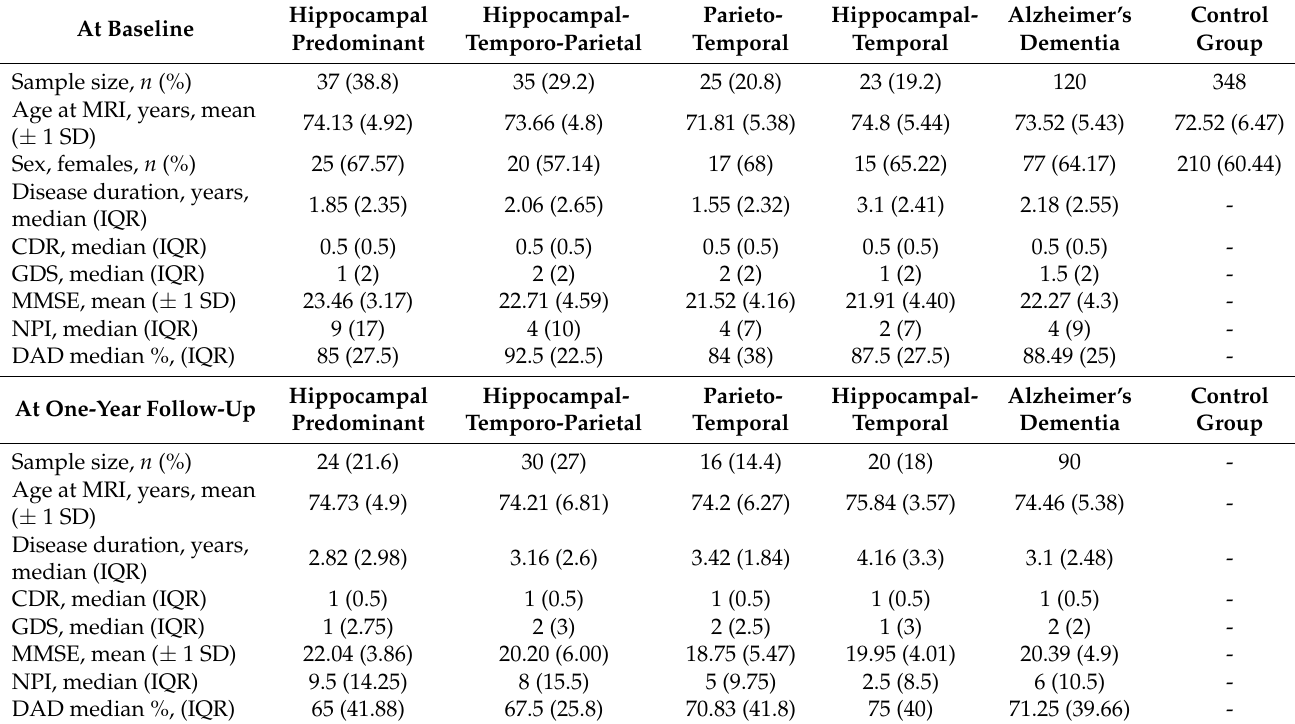
Table 2. Demographic and clinical characteristics of patients with Alzheimer’s disease at baseline and one-year follow-up. At Baseline